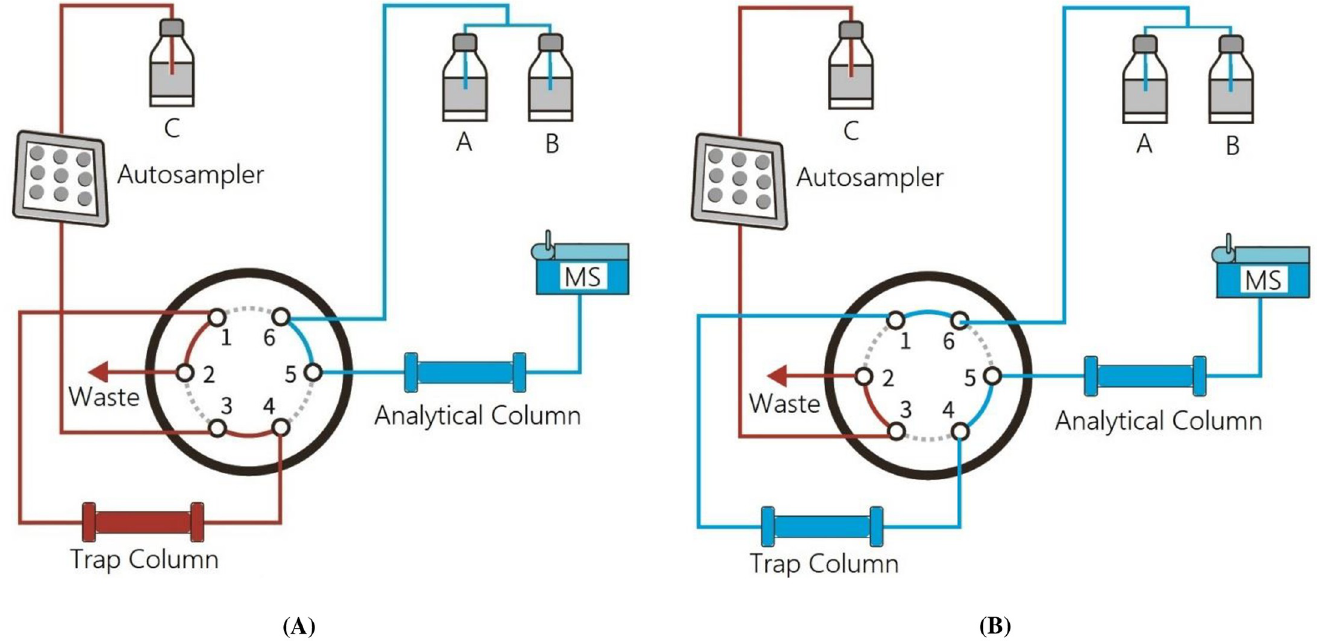
Fig 2. Schematic diagram of the online SPE and chromatographic separation system: (A) valve position I at loading samples, (B) valve position II at separating samples.